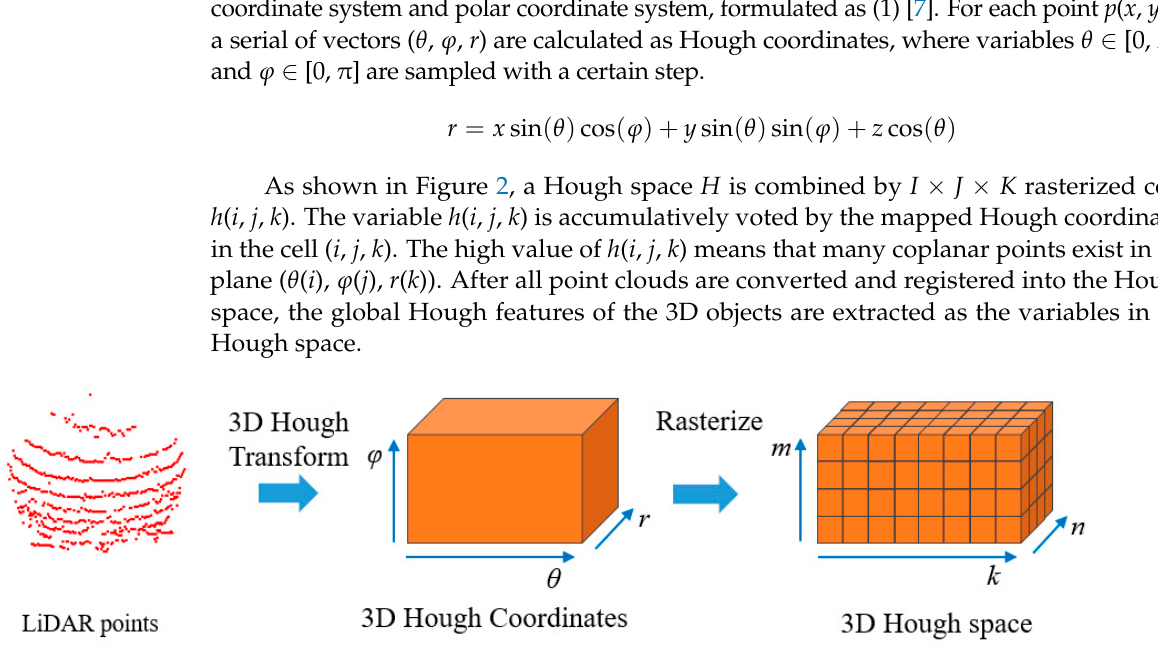
Figure 2. The 3D Hough space generation process.